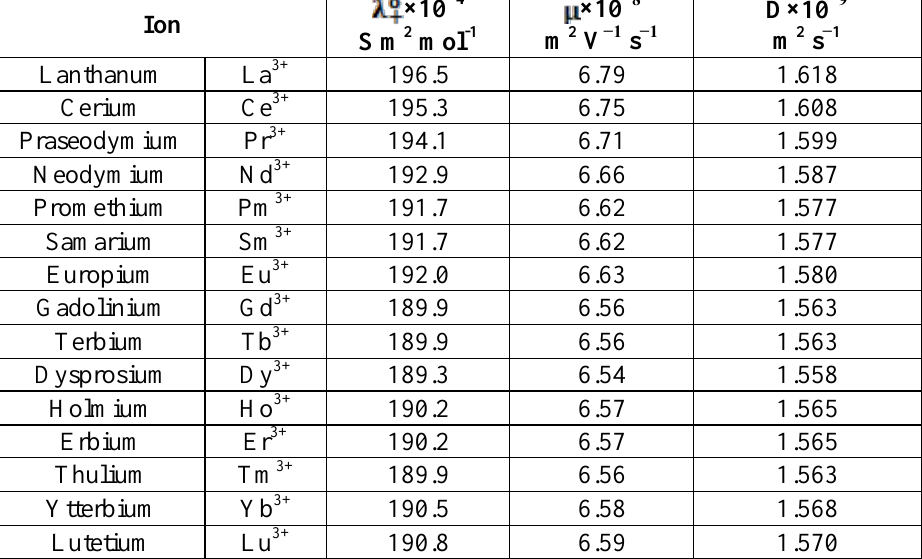
Table 1: The infinitive molar conductance λ, the mobility µ, and, the coefficient of diffusion D for lanthanide